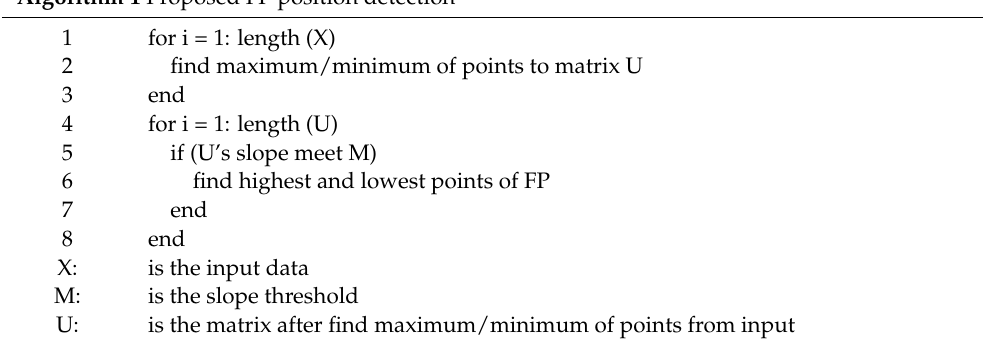
Algorithm 1 Proposed FP position detection